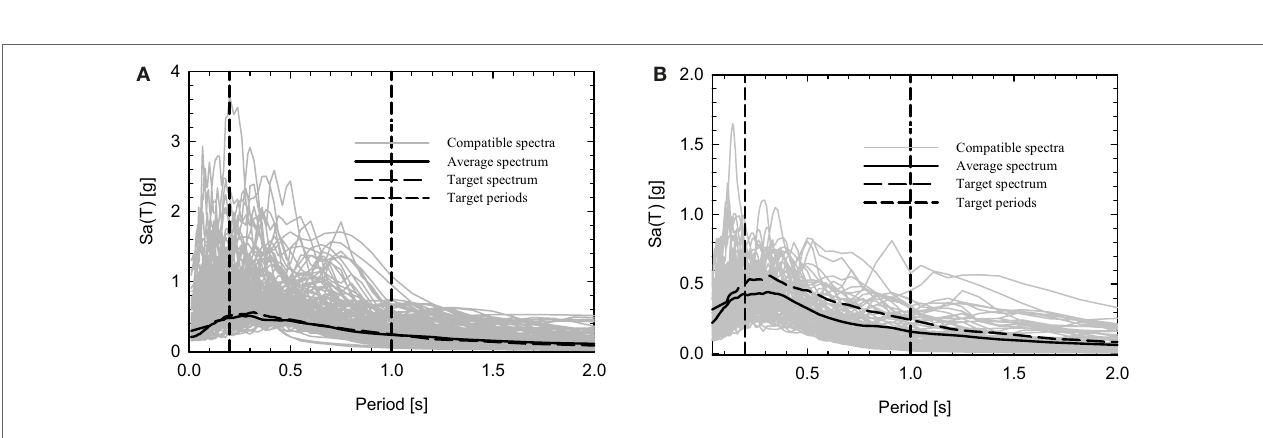
FigUre 12 | Mean deviation matching with conditional mean spectrum as target spectrum, for the (a) Peer database and (B) esMD .